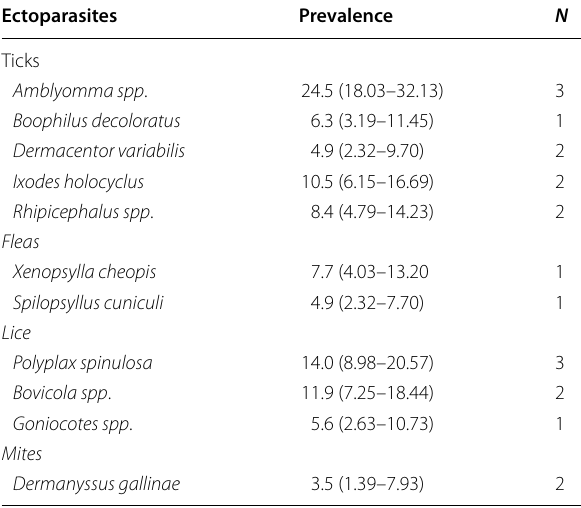
Table 1 Overall prevalence of ectoparasites recovered